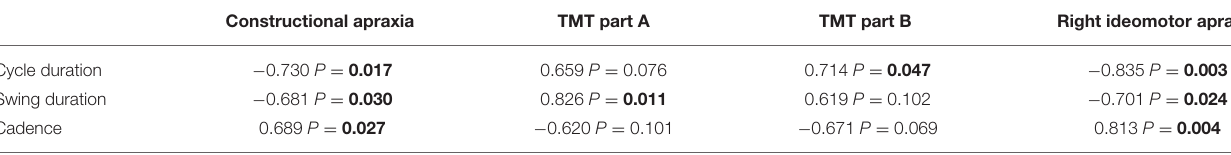
TABLE 5 | Correlation analysis between COG parameters and cognitive tests for PSP-RS.